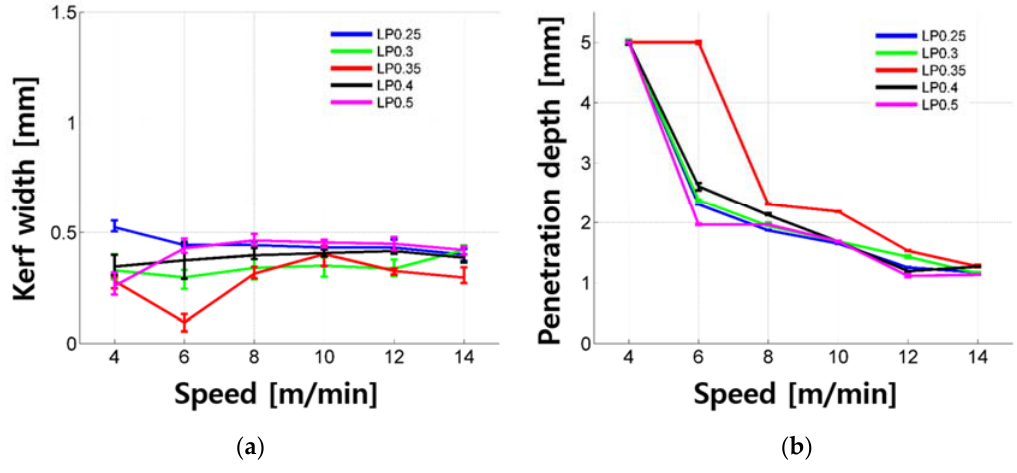
Figure 2. Kerf width ( a ) and penetration depth ( b ) vs. laser moving speed for the LP series.